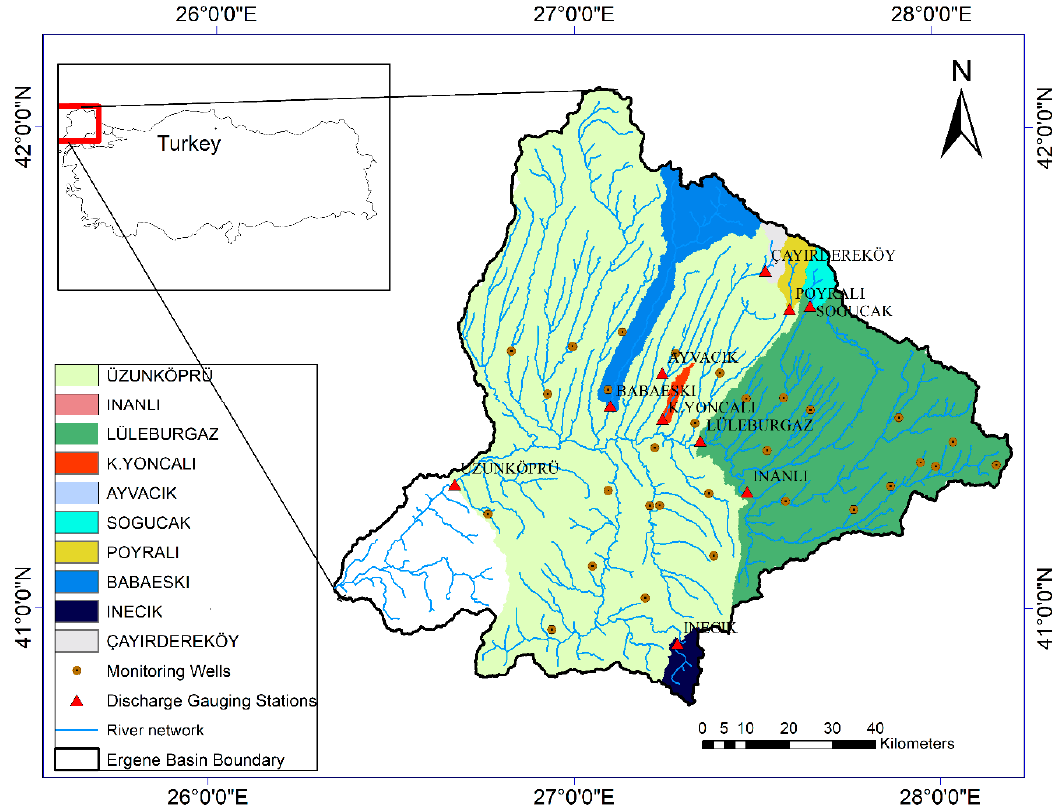
Figure 1. Ergene catchment geographic context and available gauging stations.